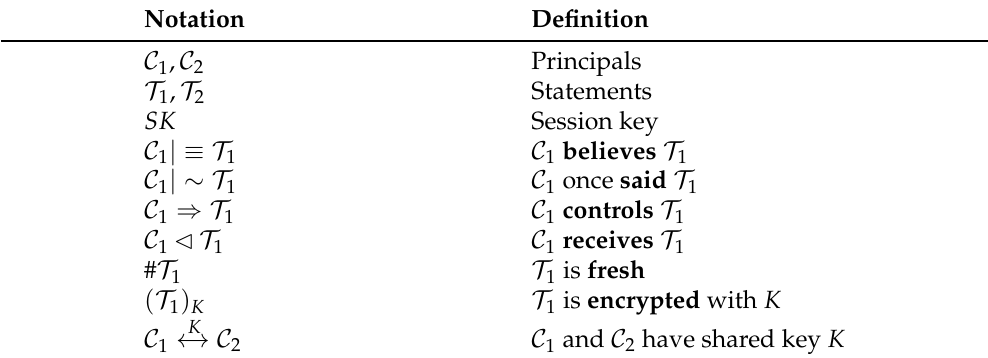
Table 3. Basic notations in BAN